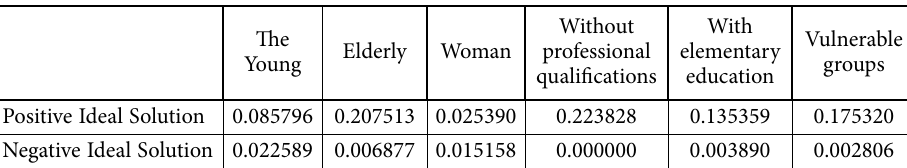
Table A3. Positive and negative ideal